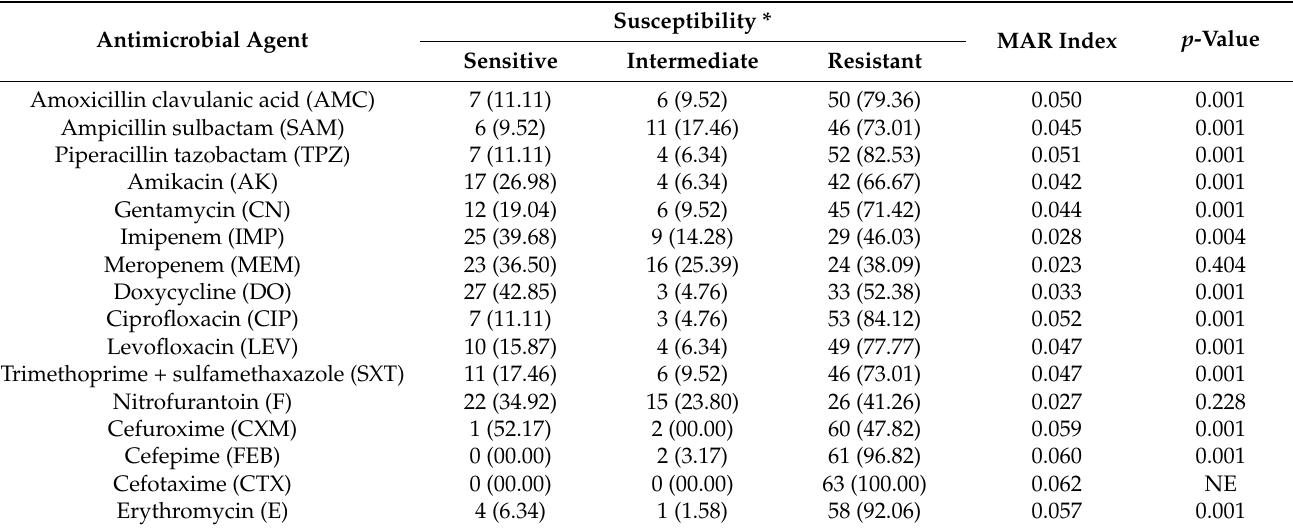
Table 2. Antimicrobial susceptibilities of Enterobacterales isolates ( n = 63) recovered from clinical urine samples.